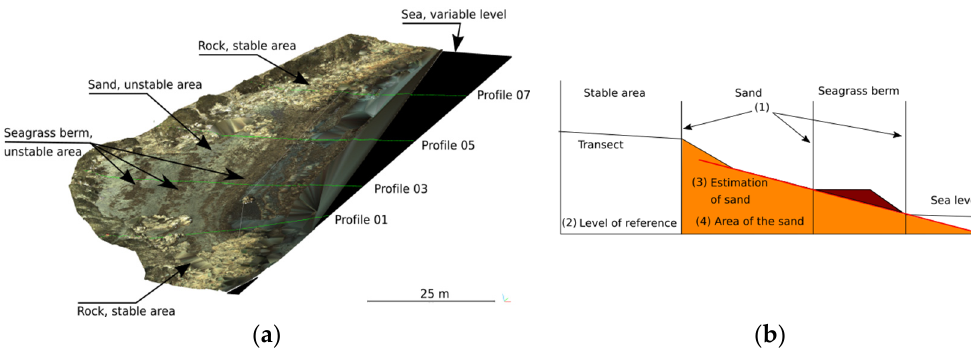
Figure 4. ( a ) Location of the analysed representative profiles; ( b ) Schematic synthesis of the applied methodology to extract the areas through profiles (stable area, sand, and beach-cast seagrass are indicated).